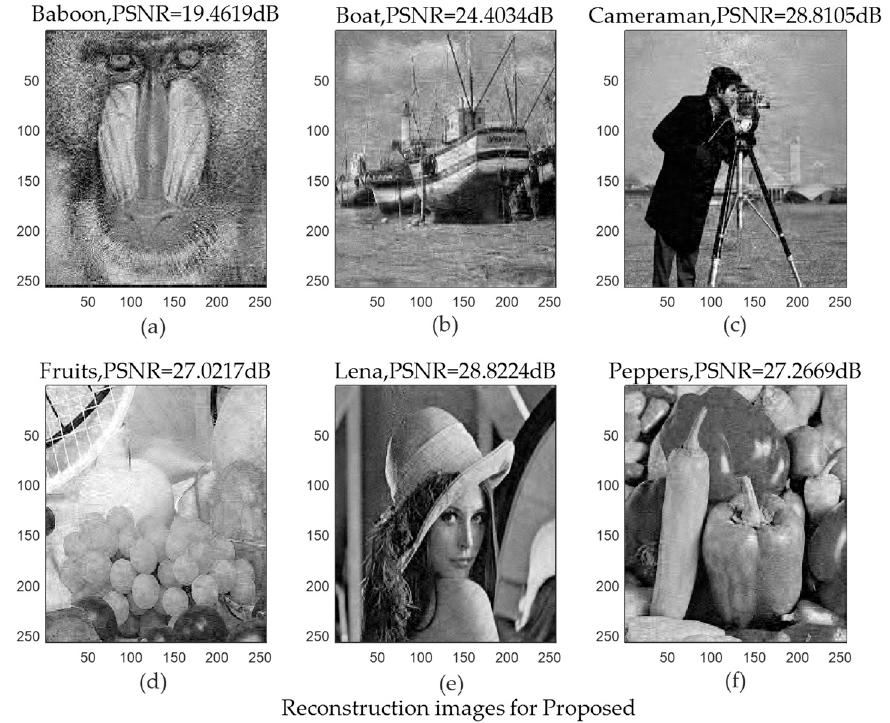
Figure 17. Reconstructed images using the proposed algorithm ( a ) Reconstructed Baboon image with PSNR = 19.4619 dB; ( b ) Reconstructed Boat image with PSNR = 24.4034 dB; ( c ) Reconstructed Cameraman image with PSNR = 28.8105 dB; ( d ) Reconstructed Fruits image with PSNR = 27.0217 dB; ( e ) Reconstructed Lena image with PSNR = 28.8224 dB; ( f ) Reconstructed Peppers image with PSNR = 27.2669 dB.